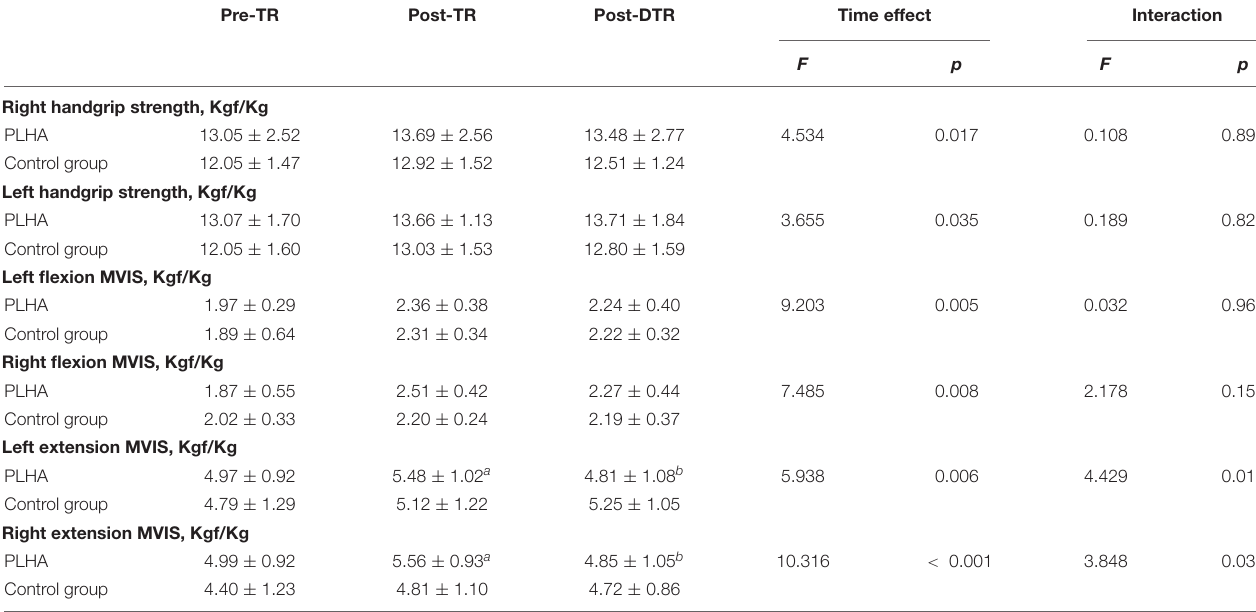
TABLE 4 | Descriptive and inferential results of Handgrip and isometric strength (Pre-TR, Pos-TR, and Post-DTR) for PLHA and